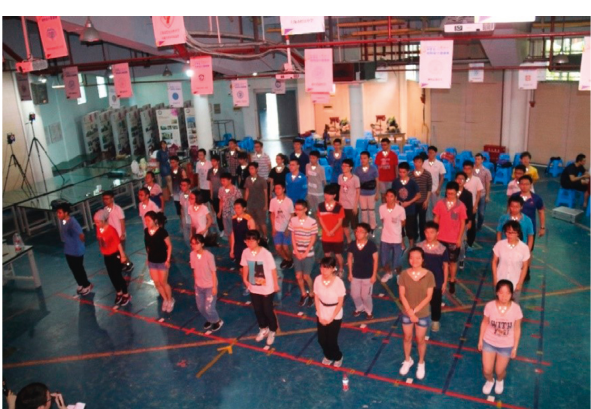
Figure 3: Experimental setup involving 18 high-speed infrared cameras.